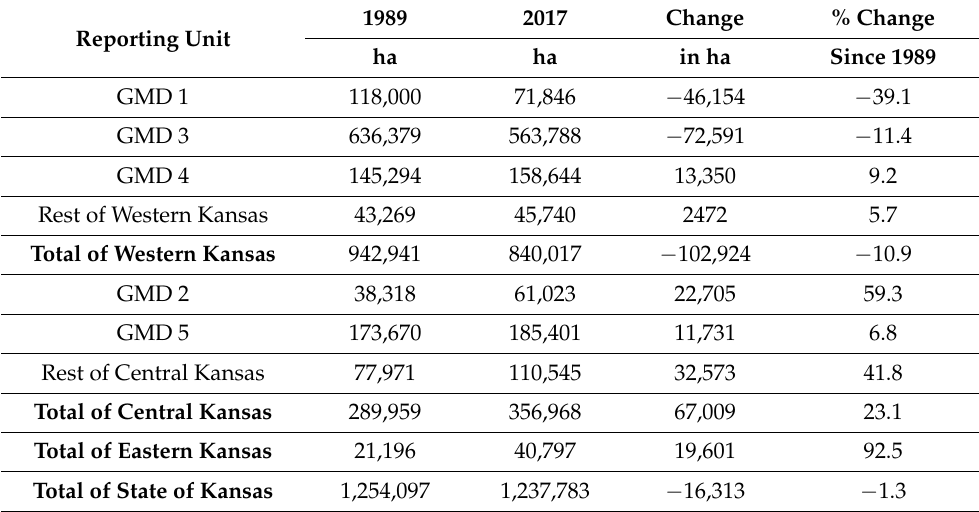
Table 3. Irrigated area reported to the Kansas Department of Agriculture, Division of Water Resources in 1989 and 2017